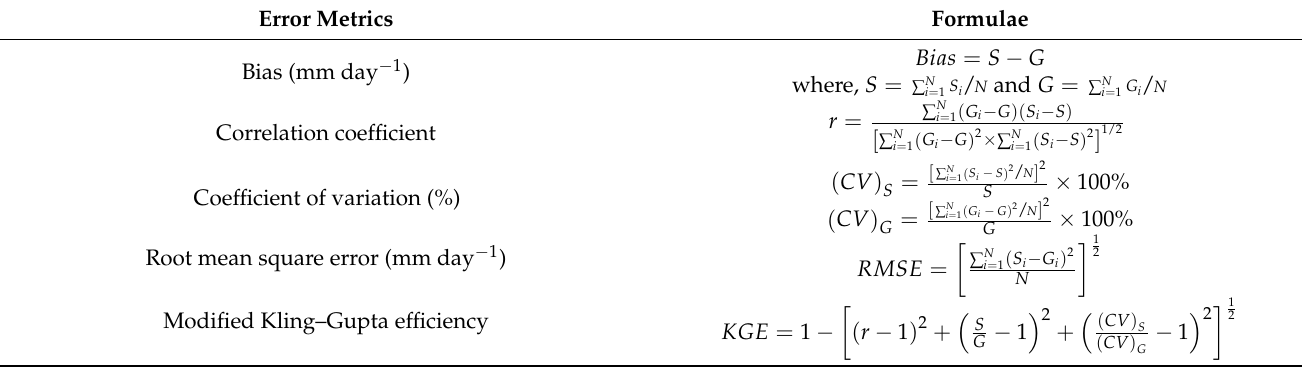
Bias = S − G where, S = ∑ N / N and G = ∑ N / N i = 1 S i i = 1 G i